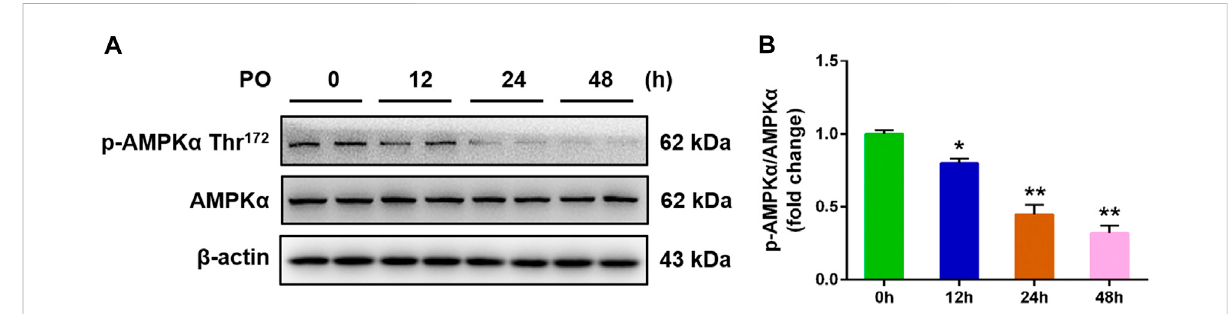
FIGURE 1 PO stimulation causes the down-regulation on the phosphorylated AMPK protein level in primary chicken hepatocytes. The primary chicken hepatocytes were stimulated with 0.75 mmol PO for 0 – 48 h. (A) Immunoblot of phosphorylated AMP-activated protein kinase α (AMPK α ) (Thr172) and AMPK α in primary chicken hepatocytes; (B) Statistical analysis of phospho ( p )-AMPK α (Thr172) and AMPK α protein level. Values represent the means ± SE. * p < 0.05 and ** p < 0.01, compared with the control